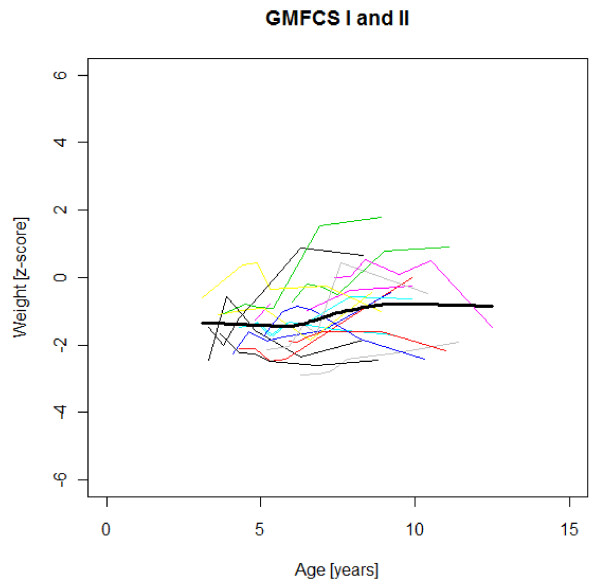
Weight z-scores in GMFCS I-II. Weight z-score at different age in 17 children with CP spastic diplegia, GMFCS I-II. Their mean z-score development with age is shown in black.